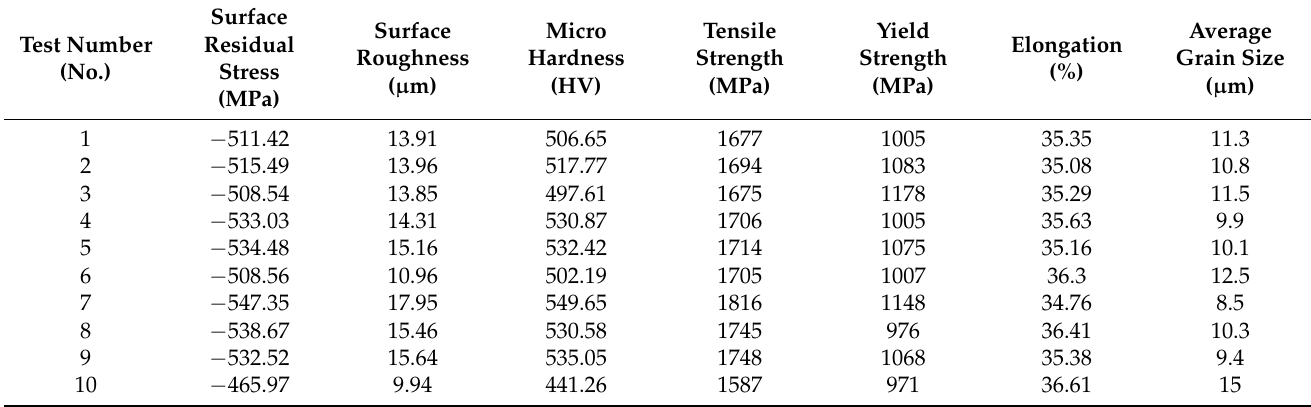
Table 4. The statistical table of test